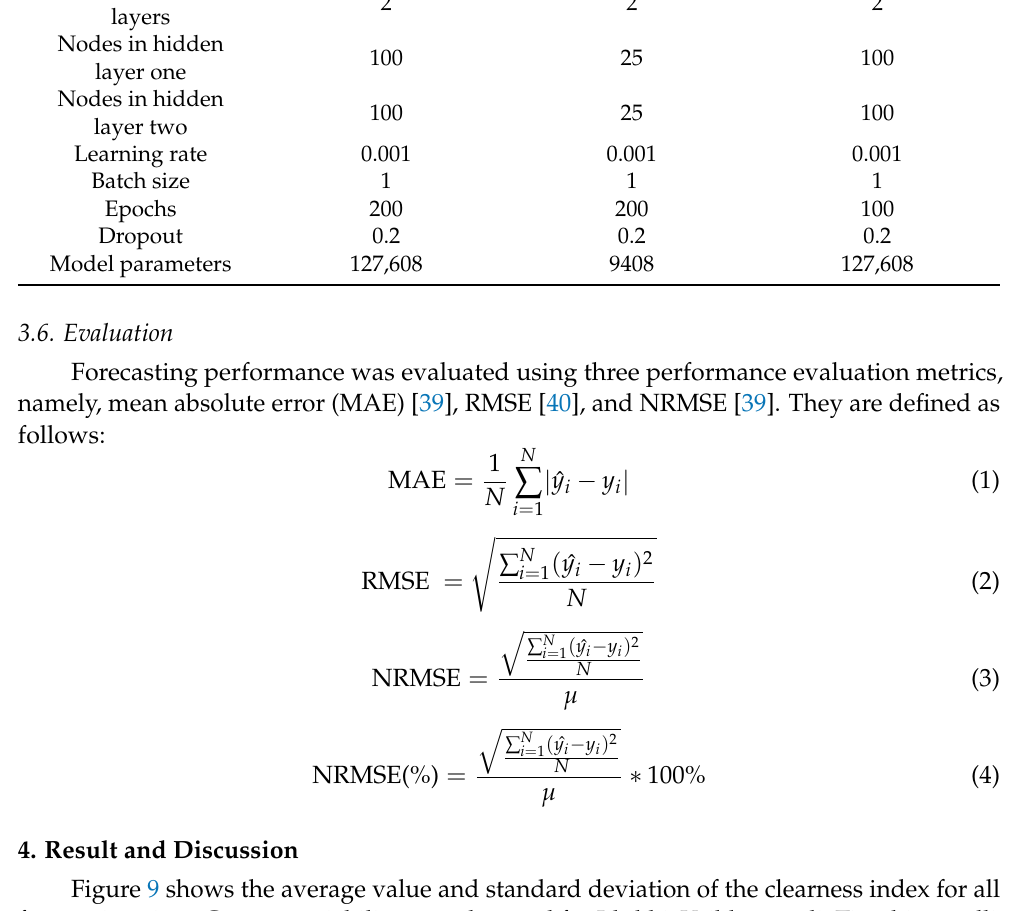
Table 5. Optimal hyperparameter settings for CB-LSTM in different cloud conditions. Hyperparameters Broken Clear/Sunny Broken/Overcast Number of